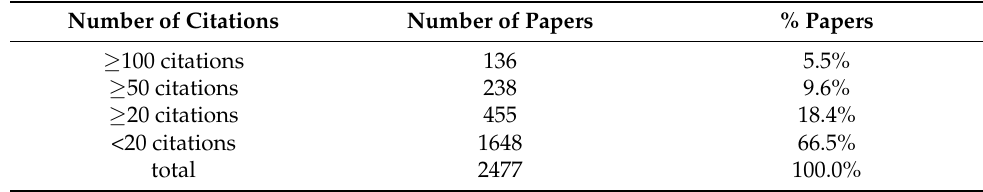
Table 3. Citation structure of remanufacturing